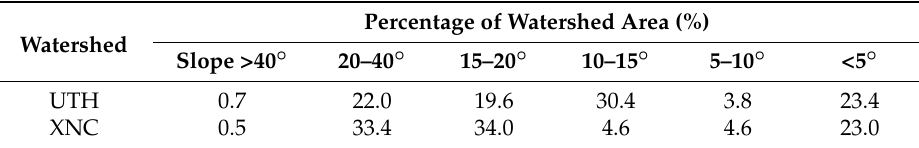
Table 7. Averaged slopes in two studied